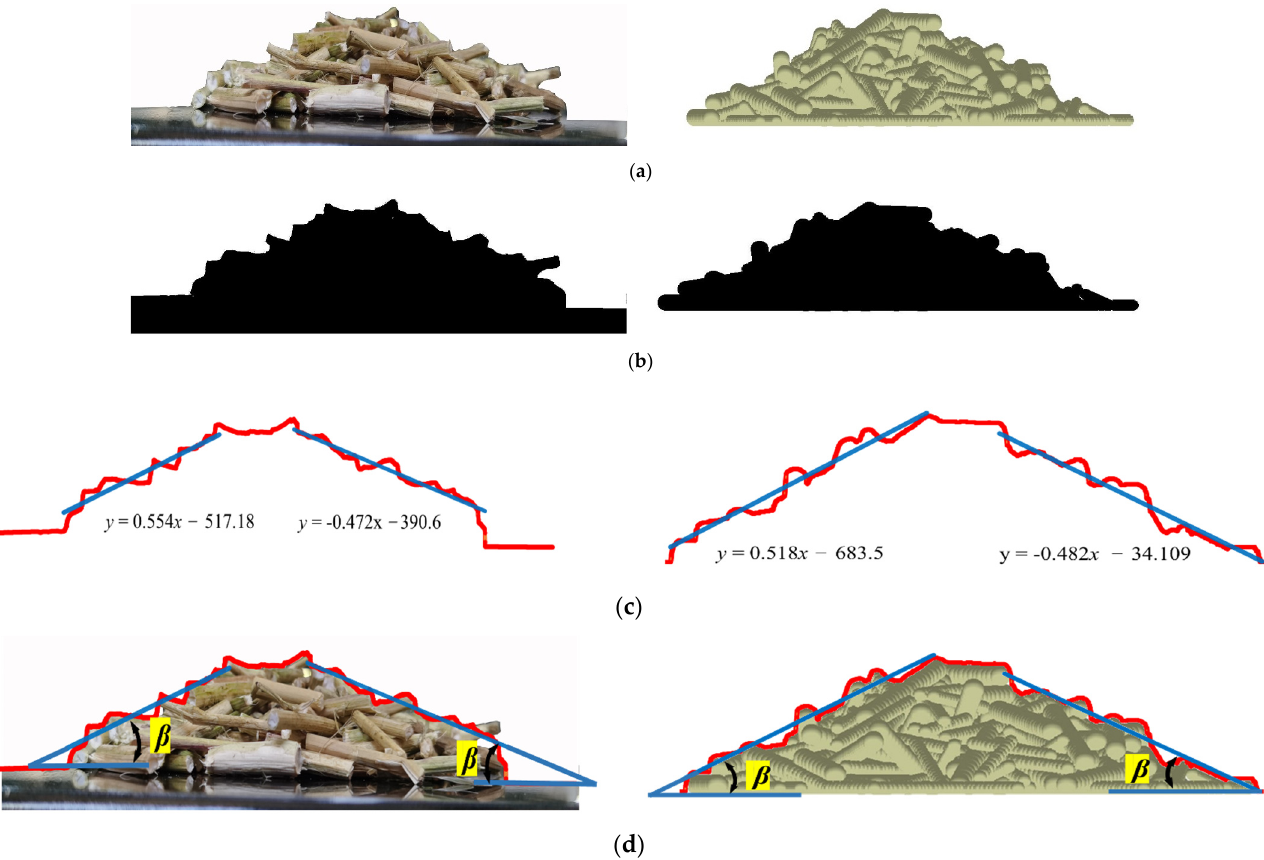
Figure 9. Rape stem repose angle test. ( a ) Image of rape stem pile; ( b ) Binarized image; ( c ) Boundary Fitting; ( d ) Test result.